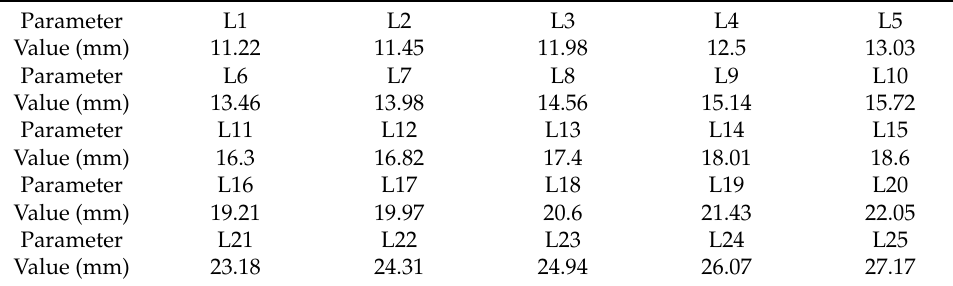
Table 3. List of optimized parameters for Tag 1.